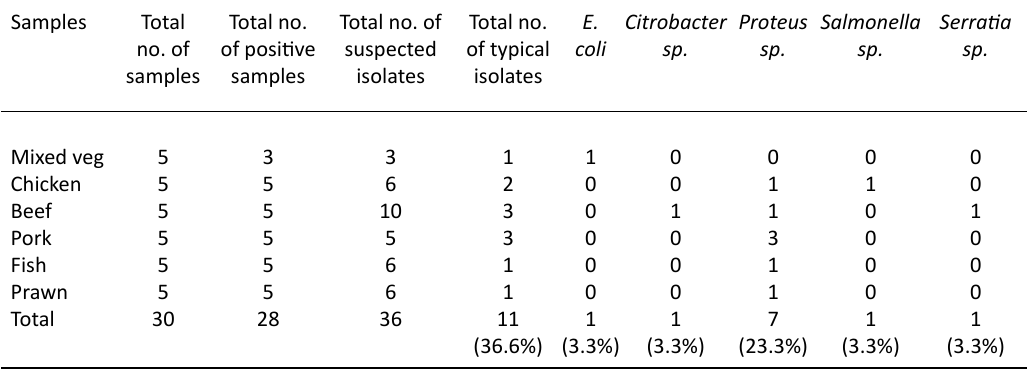
Table 1. Different members of Enterobacteriaceae family isolated from ready to cook chilled food samples Samples